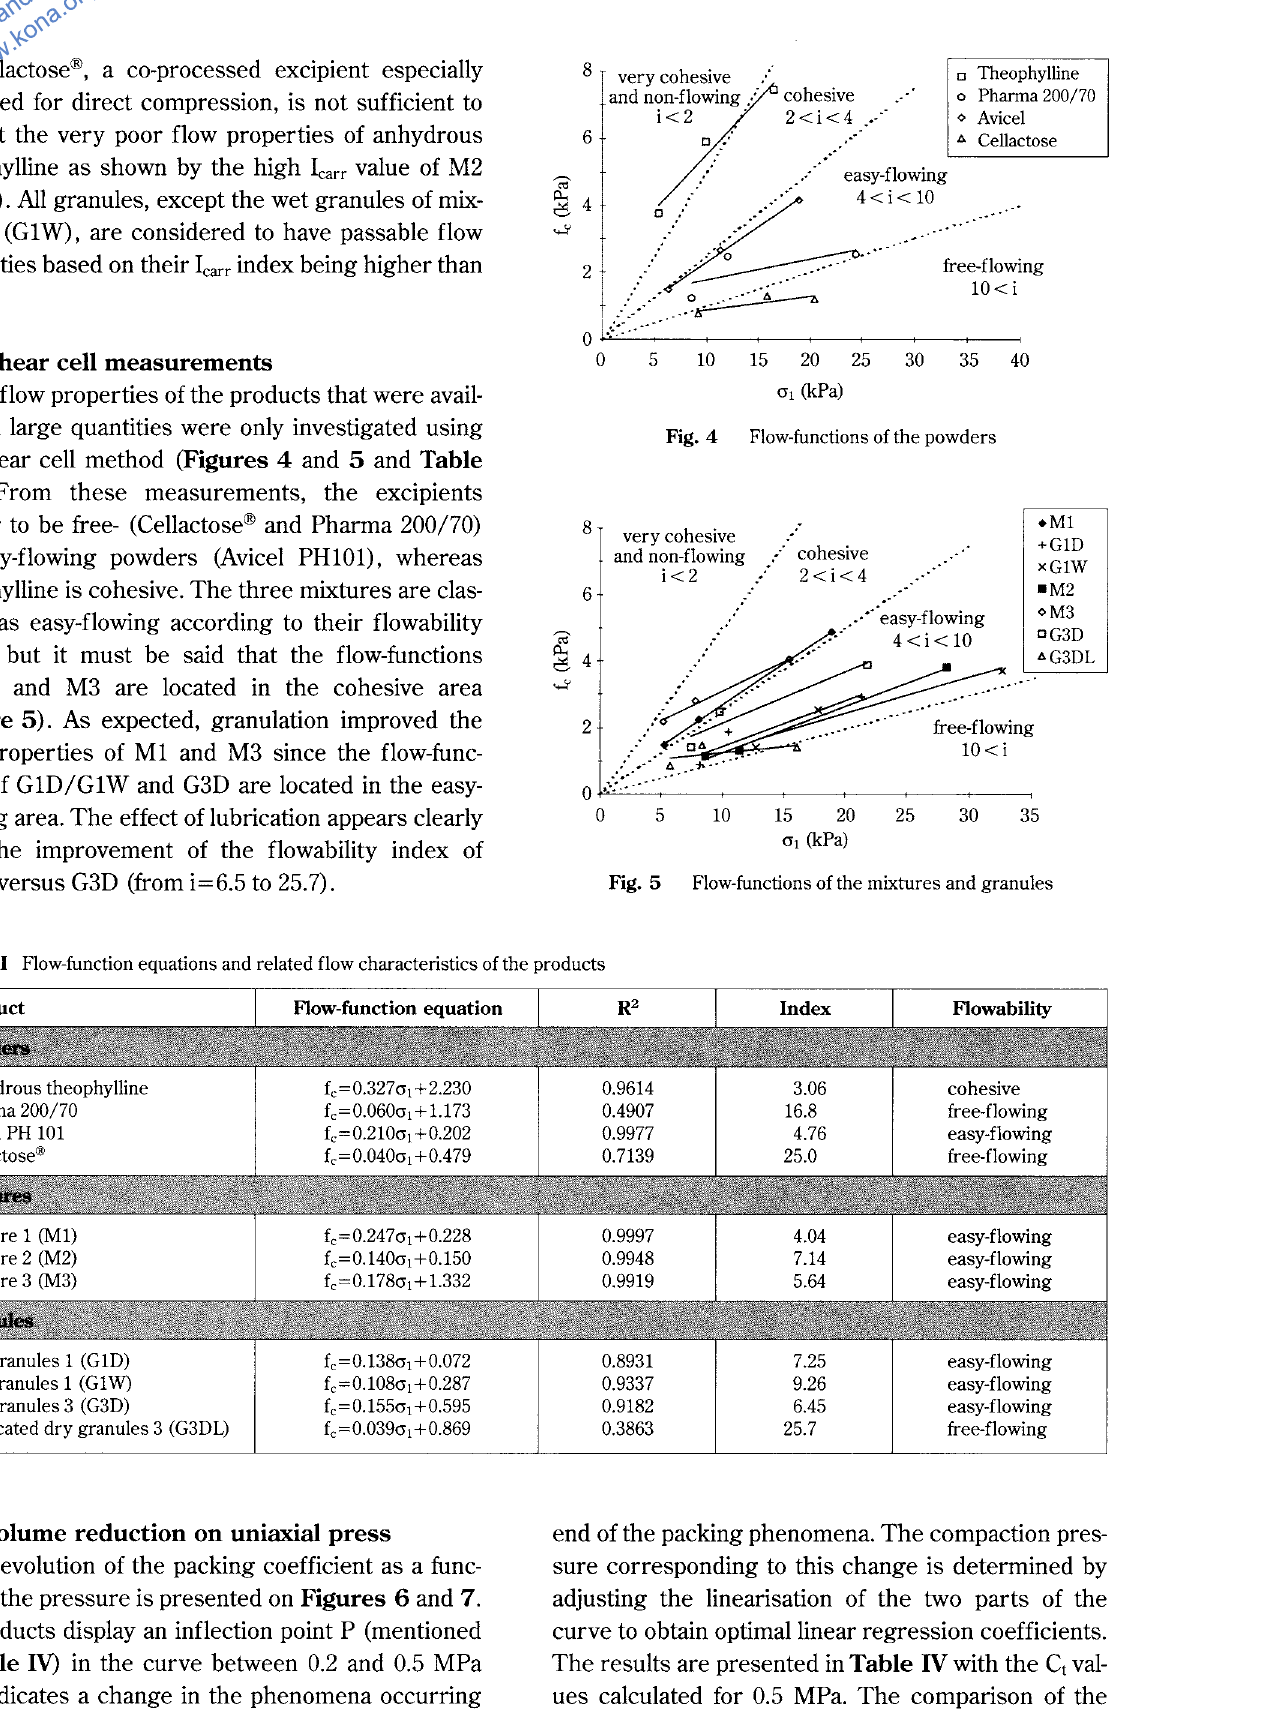
Fig. 4 Flow-functions of the powders